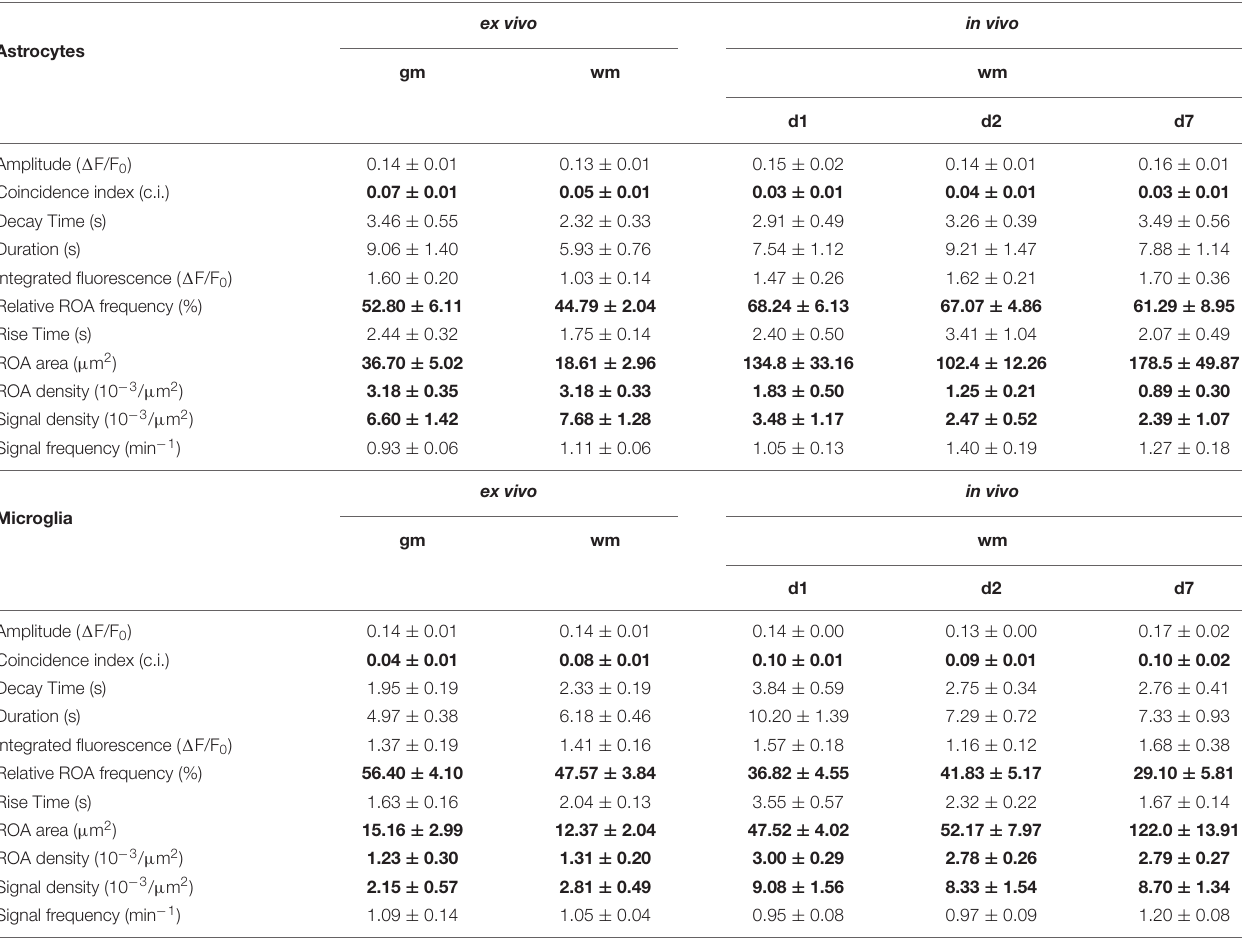
Highlighted values refer to parameters enabling clear data